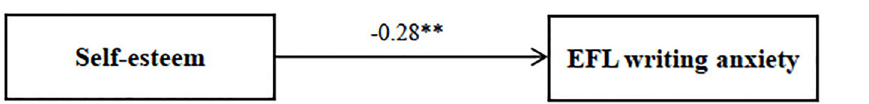
Fig 1. Standardized solutions for the structural equation model of self-esteem and EFL writing anxiety. Note: ** P < 0.01. The standardized path coefficient is illustrated on the unidirectional arrow path. ** The coefficient of the path is significant at the P < 0.01 level. Abbreviations: EFL, English as a foreign language.